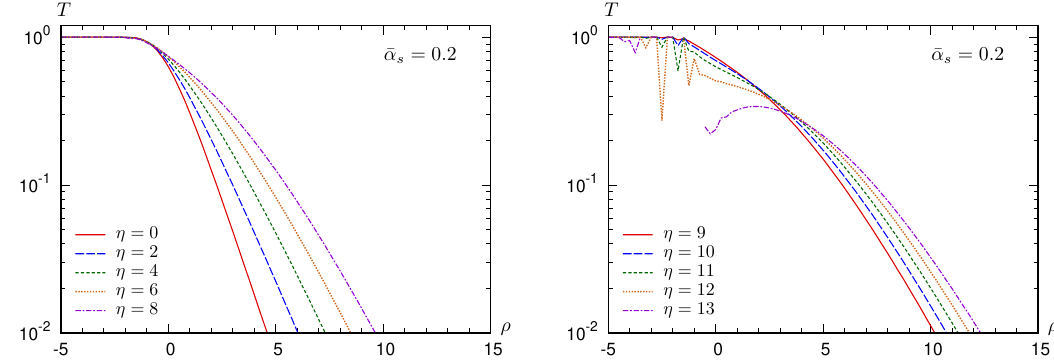
Figure 5 . Left: the front for small values (cid:17) as obtained by the numerical solution to eq. (4.32). As in the case of BFKL evolution, the solution seems to be physically meaningful in this rapidity regime. Right: the front for larger values of (cid:17) as obtained from the same equation. Again, as in the BFKL case, an instability is formed and renders the solution